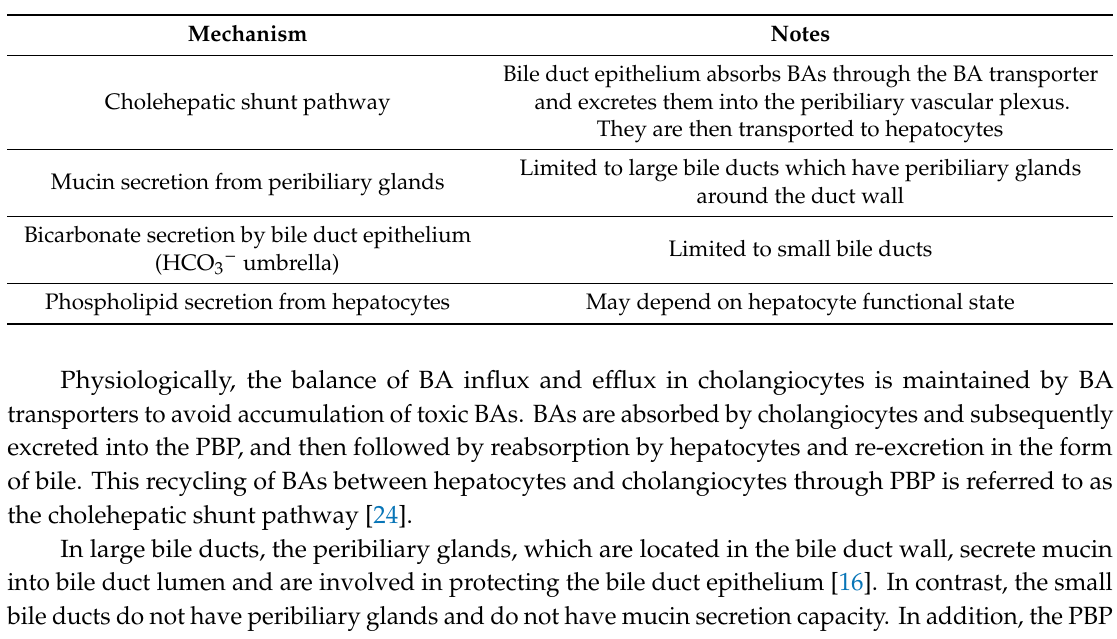
Table 1. Bile duct epithelium protection mechanisms from the aggressive bile acids